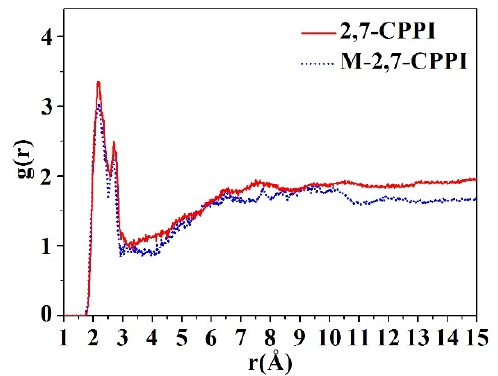
Figure 5. The RDFs of the hydrogen atoms of − HN − in carbazole and oxygen atoms of O=C − in imide rings for M-2,7-CPPI and 2,7-CPPI.